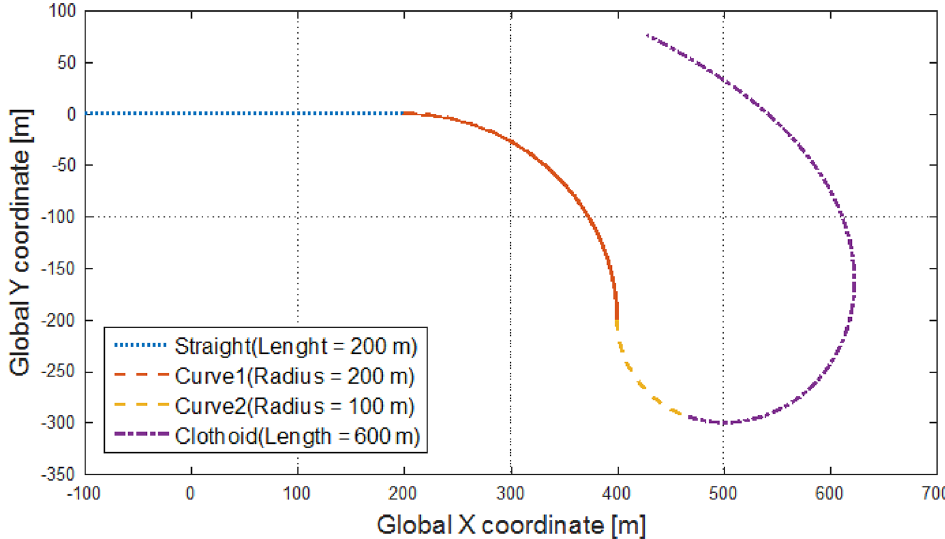
Fig 1. Desired path. Desired path for path-following control is plotted in this figure. This path comprises of four parts: a straight part, two curves, and a clothoid part. The straight part is used to prove the fulfilment of the proposed controller in this paper by setting the starting point, which is deviated from the desired path. By using the two curves and the clothoid part, the ability of the controller to perform path-following control will be demonstrated.